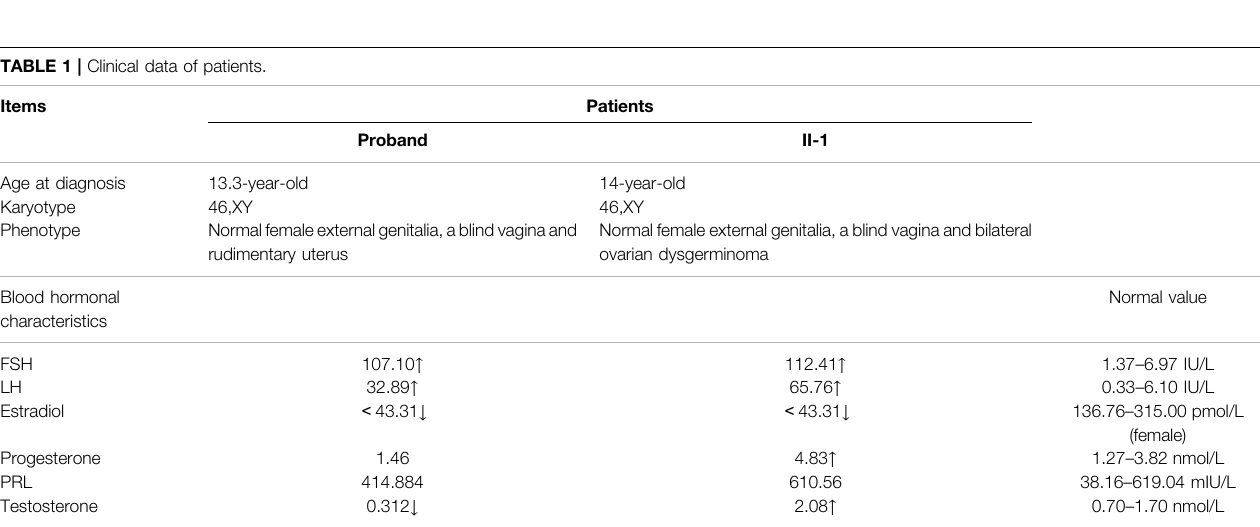
TABLE 1 | Clinical data of